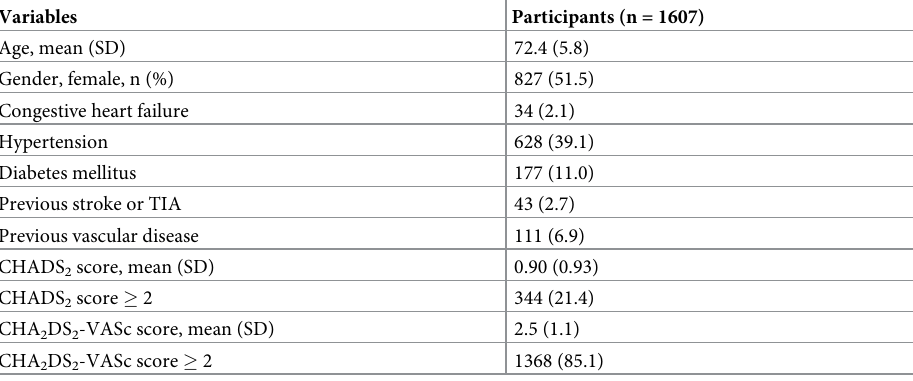
Table 3. Clinical characteristics of the participants.